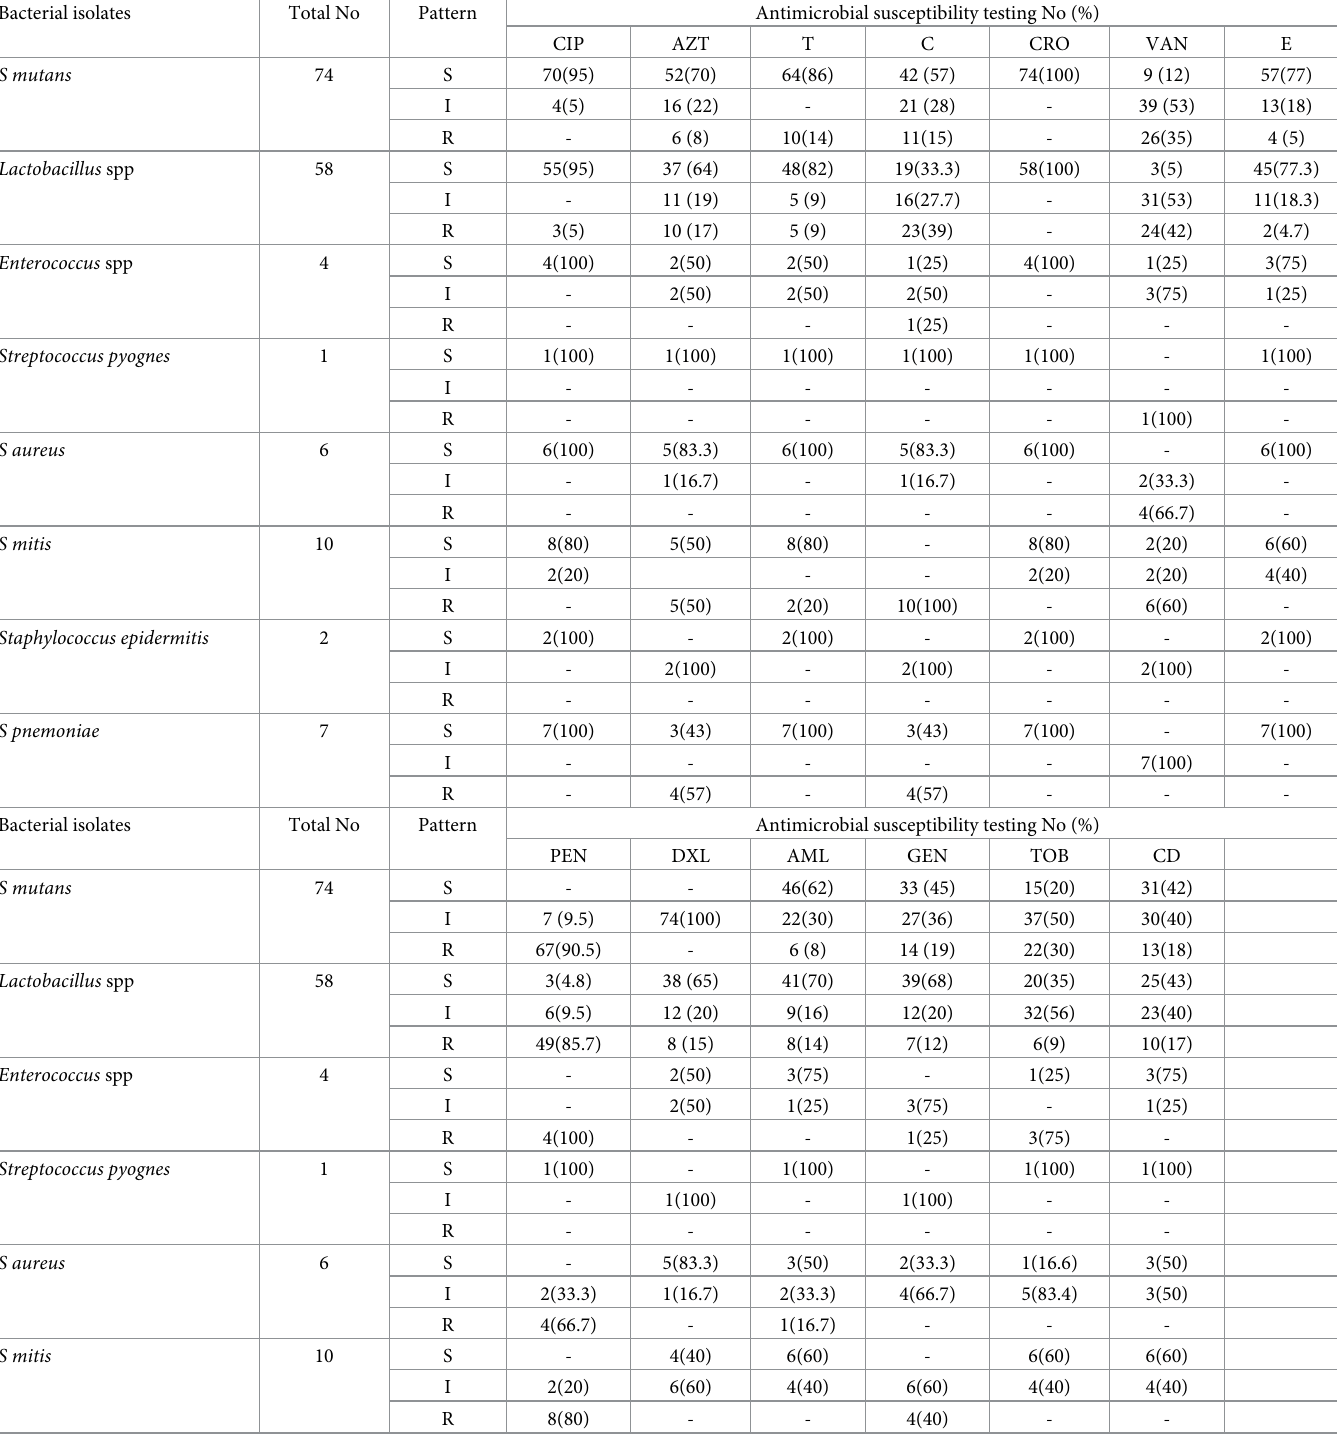
Table 4. Antimicrobial susceptibility pattern of gram-positive isolated bacteria from dental caries patients attended at Hiwot Fana comprehensive specialized uni- versity hospital, dental clinic, Harar, Eastern Ethiopia from April to June 2021. Bacterial